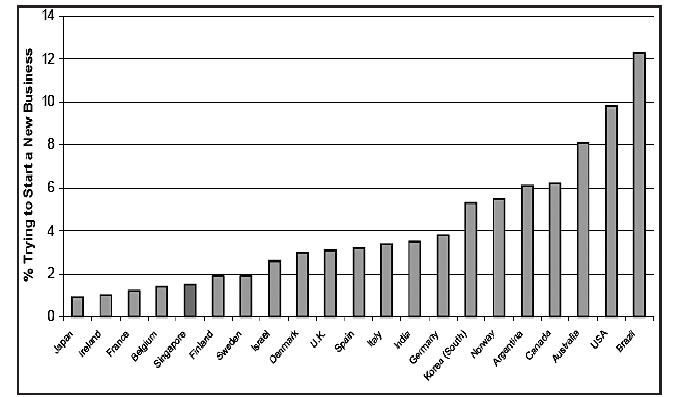
Figure 2. Total Entrepreneurial Activity by Country